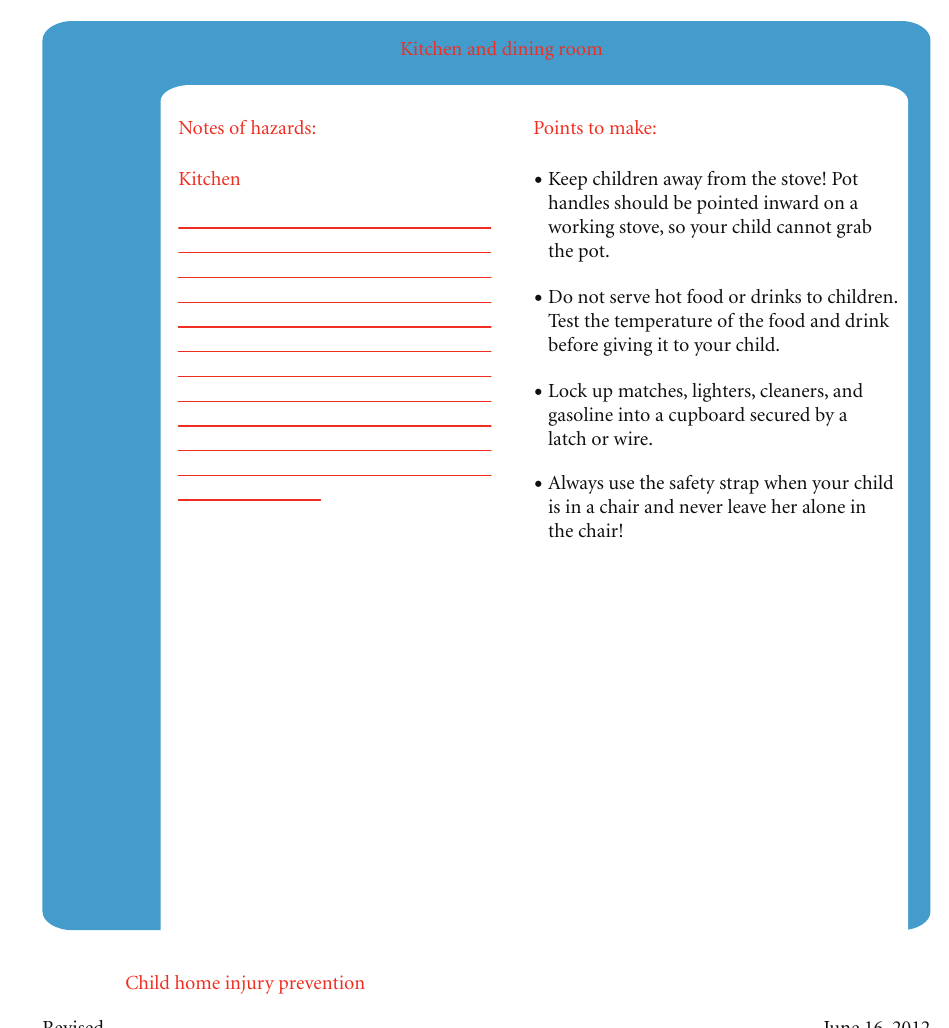
Figure 4: Example from In-Home Tutorial Guide in